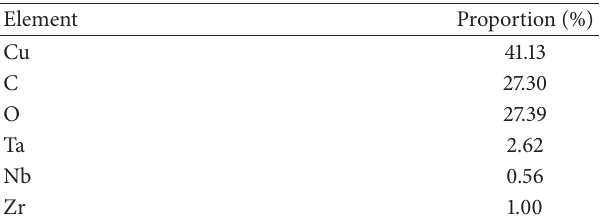
Table 2: Nanocopper, EDX analysis of element proportion. Element Proportion